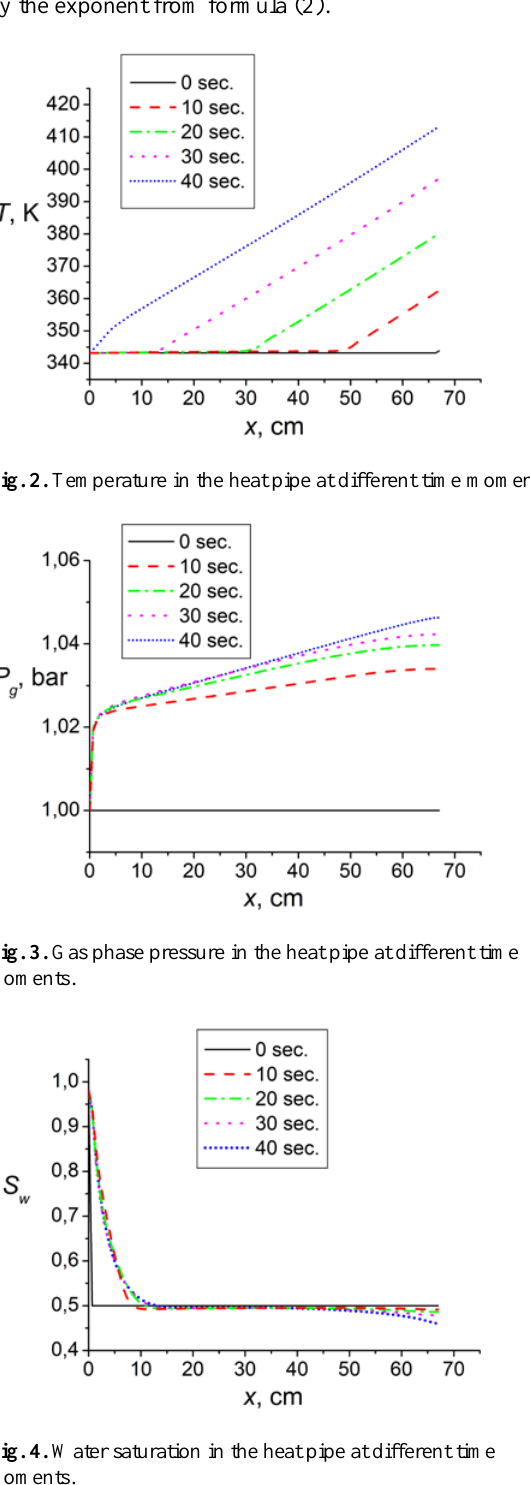
Fig. 4. Water saturation in the heat pipe at different time moments.